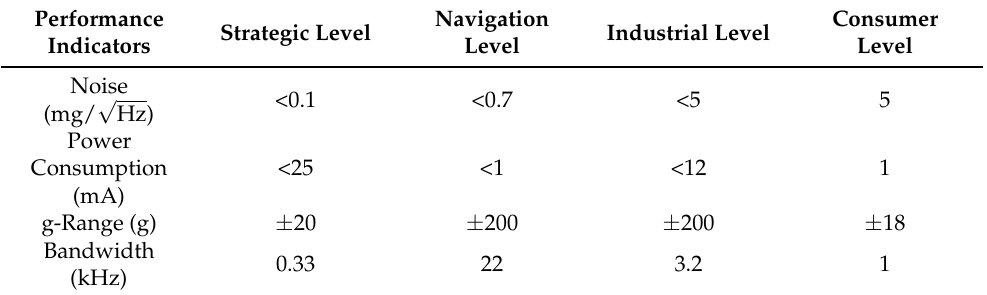
Table 2. Approximate range of key accelerometer parameters for different classes of